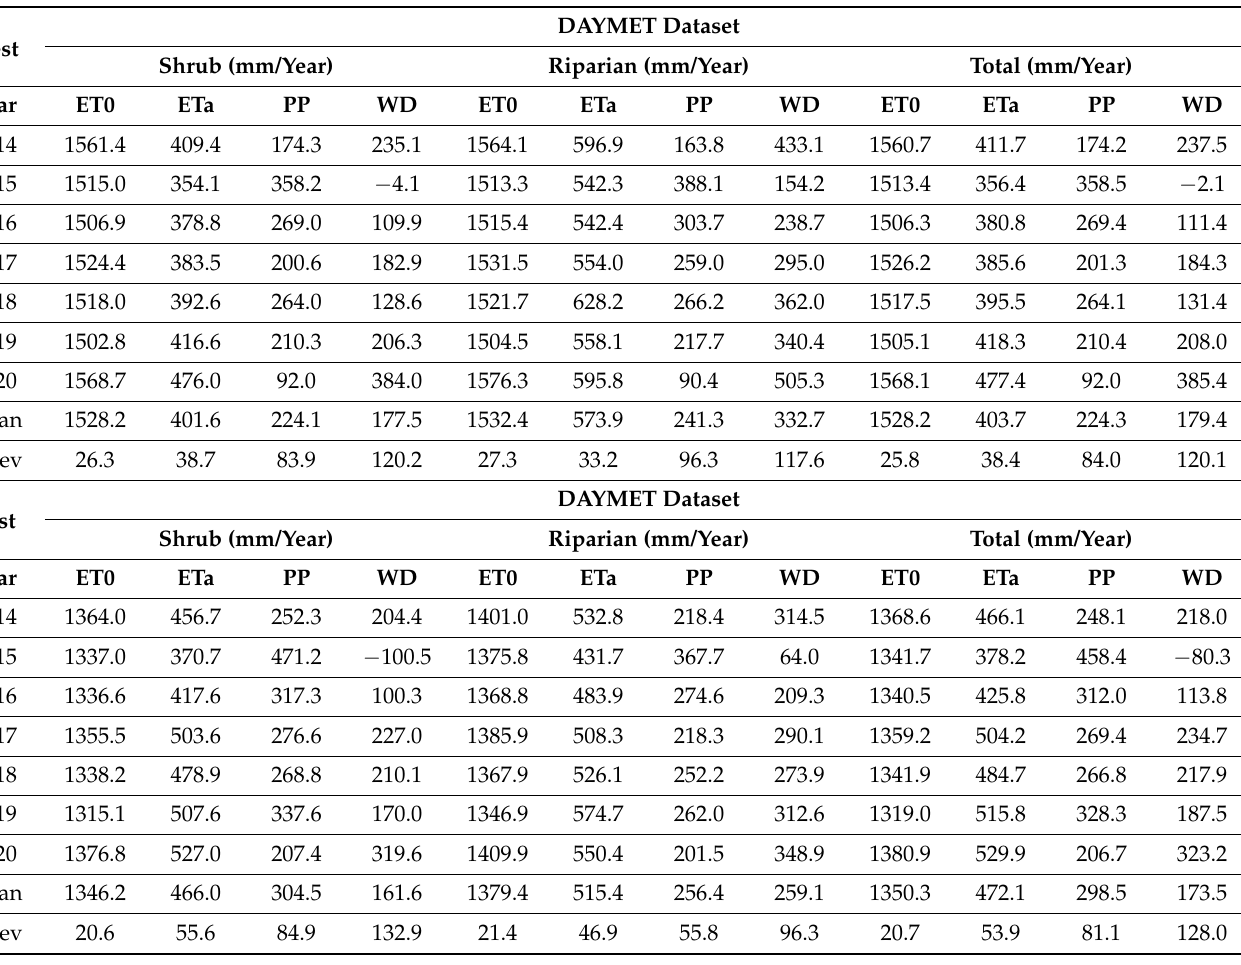
Table 4. Water metrics (ETo, ETa, PP, WD) using Daymet gridded weather data (1 km) and Landsat for each year, their mean and standard deviation, calculated for the riparian ROI by ground area for shrubs, trees, and total riparian vegetation divided into the West (top) and East (bottom) sides of the study area within the Navajo